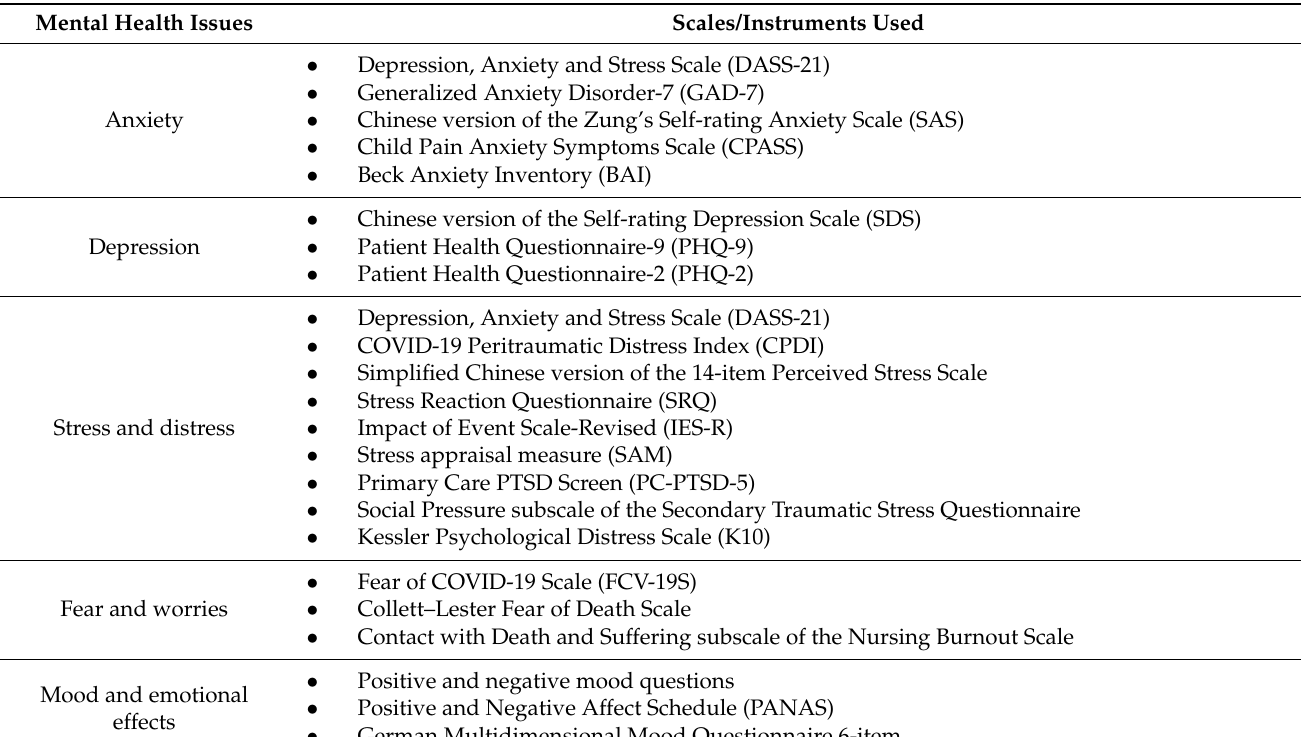
Table 5. Scales/instruments used to diagnose various mental-health-related issues among partici-